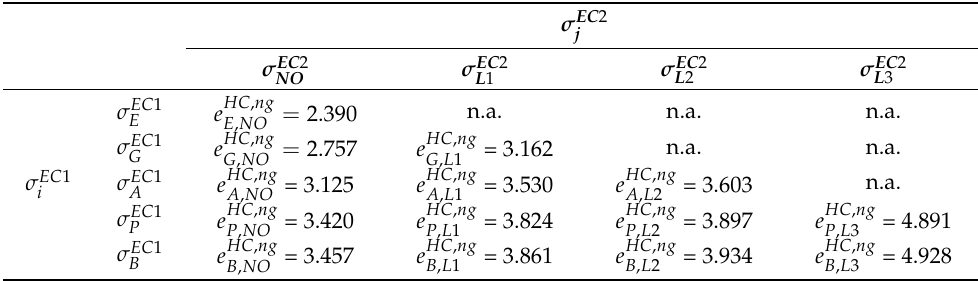
Table 7. Computational results of the virtual HC emission in kg within one cycle.